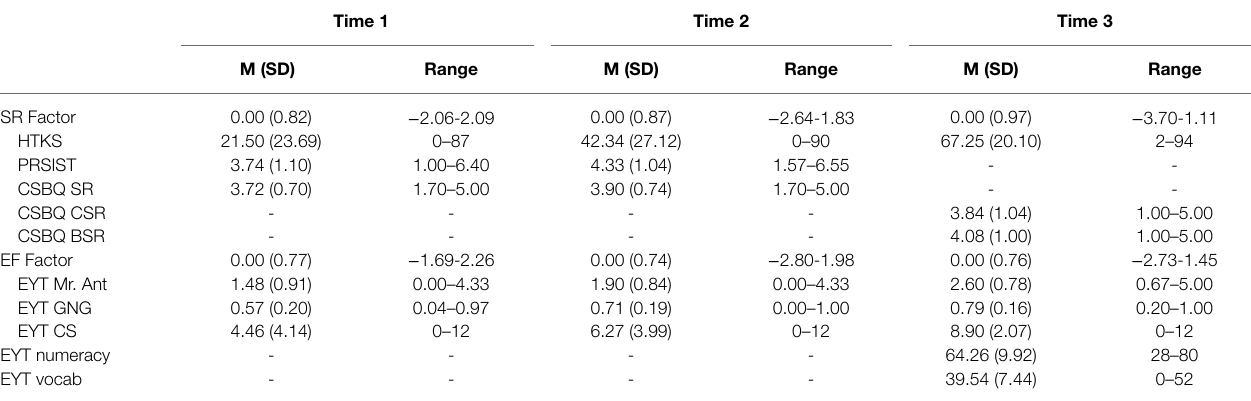
TABLE 1 | Descriptive statistics for modelled